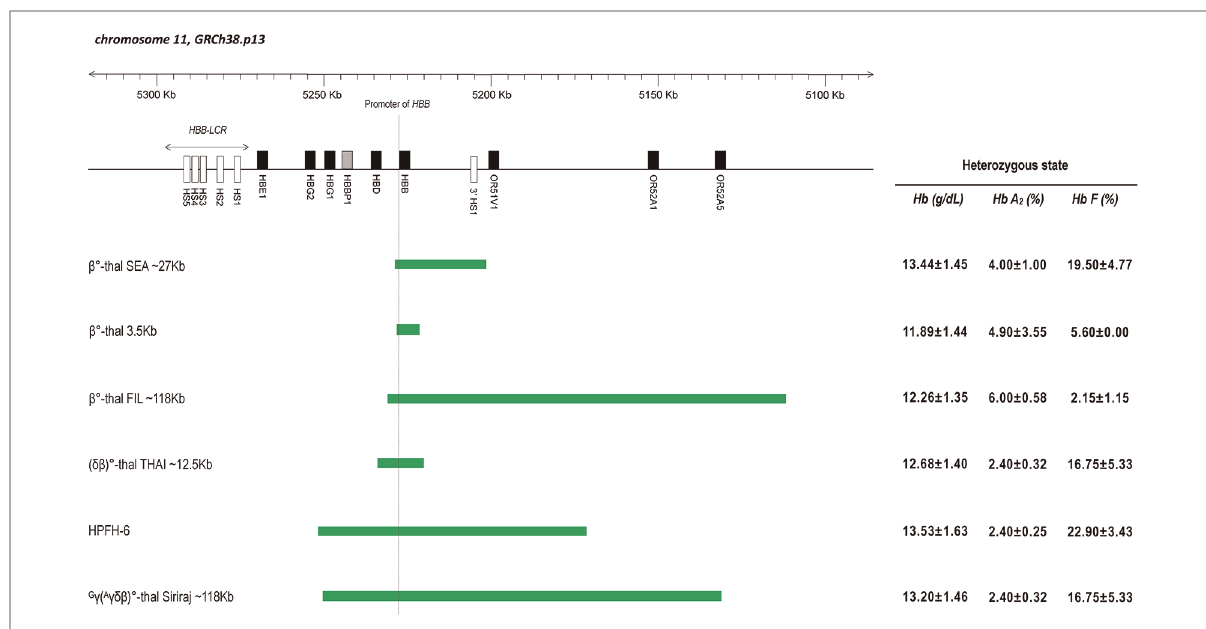
FIGURE 1 Scheme of β -globin gene cluster in chromosome 11 based on the coordinate from genome reference consortium human build 38 patch release 13 (GRCh38.p13). Genes are indicated by black fi lled rectangular; pseudogene is indicated by shaded rectangular; DNA Hypersensitive Sites (HS) are indicated by empty rectangular. The dashed line indicates the promoter area of the β -globin gene ( HBB gene). The region of various deletion types is shown by the green bar. On the right side is the mean value of Hb, Hb A 2 and Hb F levels found in the heterozygous state for each type of